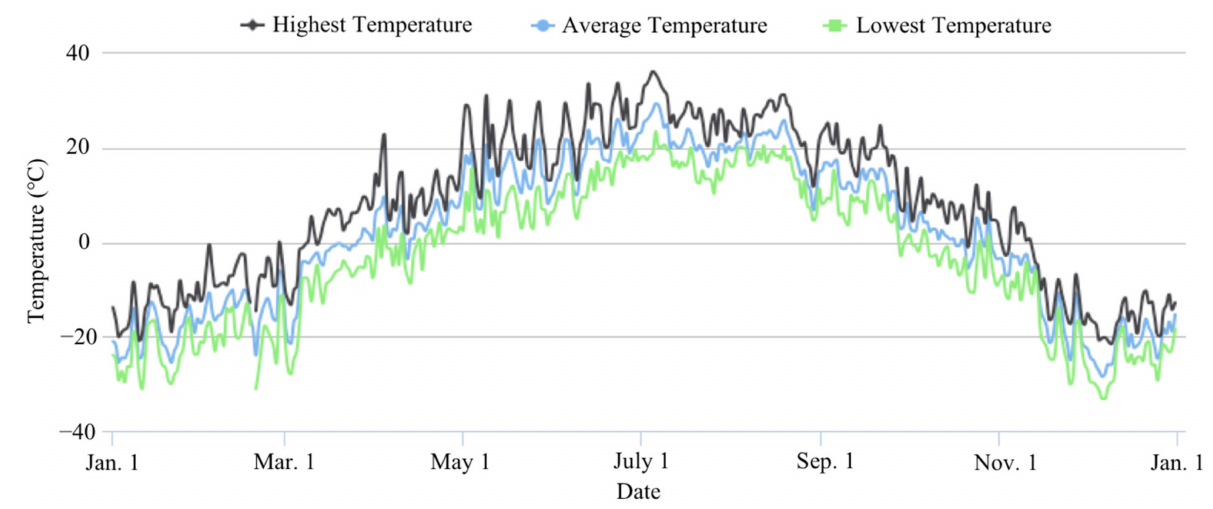
Figure 27. Annual ambient temperature of Heihe, China in 2017 [33]. With the ambient temperatures in colder 2013, the optimal solution of AMGO is 0.5149. The corresponding optimal scheme is p min = 13.28 MPa, N ac = 12, N at = 6, b ac = 0.9365, b at = 1.0684. While for the hotter 2017, the optimal solution is 0.5121. The corresponding optimal scheme is p min = 13.06 MPa, N ac = 12, N at = 6, b ac = 0.9288, b at = 1.0754.